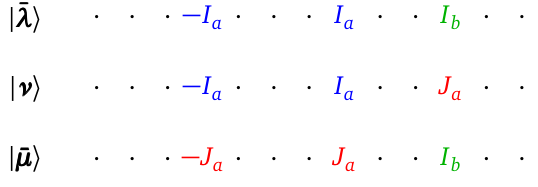
Figure 7: Cases (iii) and (iv) of type II